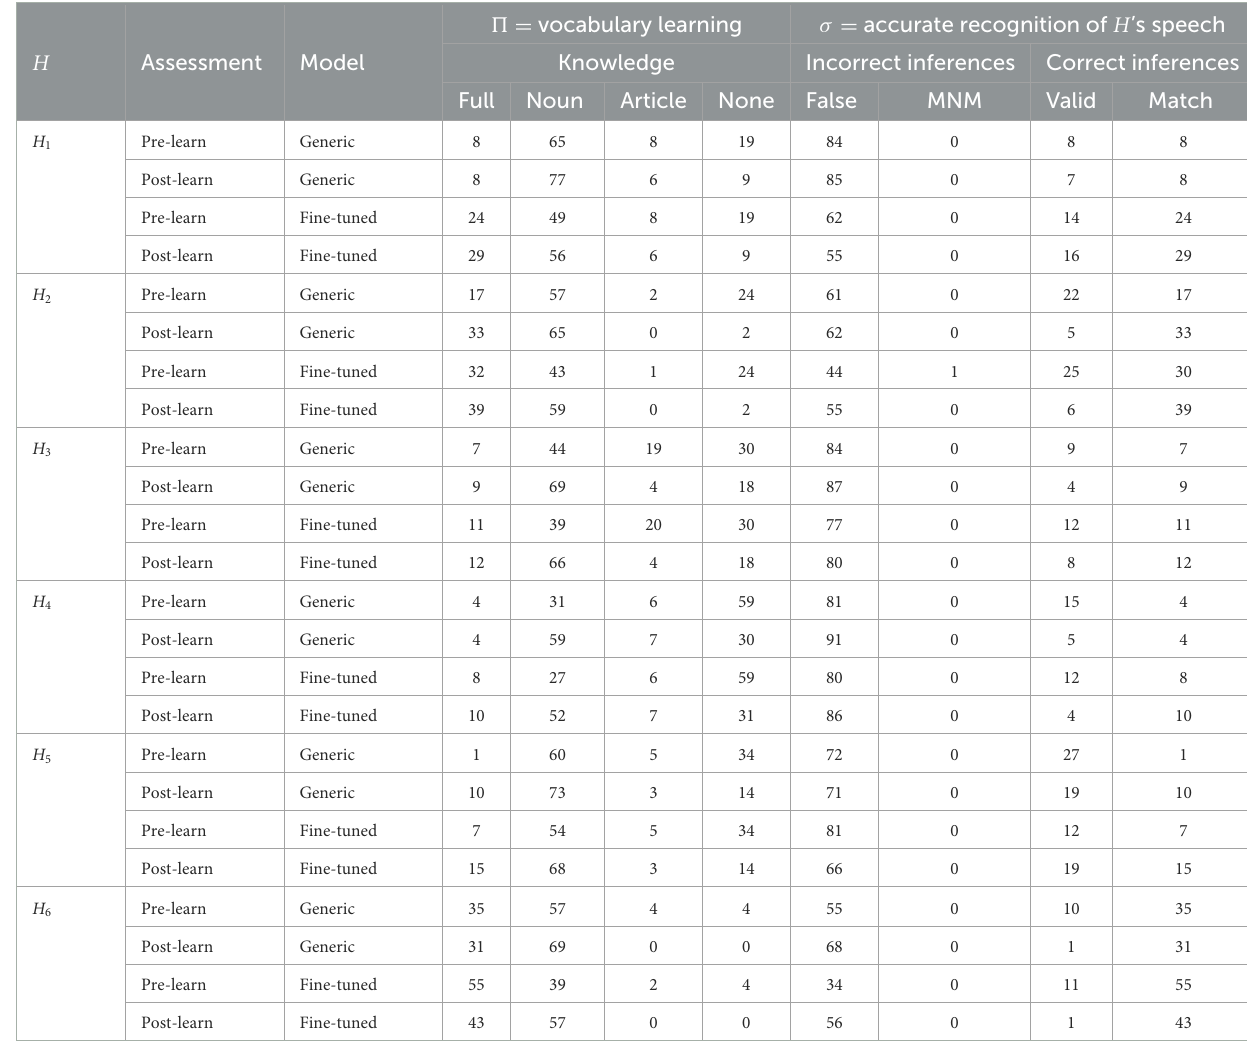
TABLE 4 Analytic overview of the development of human ( 5 ) and machine ( σ ) competences for all combinations of speech-recognition models and pre-, resp. 5 = vocabulary